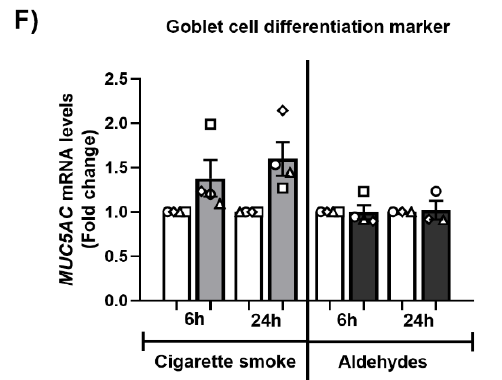
Figure 9. Transcript levels of basal epithelial cell marker KRT5 are decreased in response to CS exposure. Differentiated human primary bronchial epithelial cells (PBEC) from non-COPD subjects ( n = 4 donors) were exposed to smoke of one Marlboro Red cigarette (CS), or a mixture of acetalde- hyde, acrolein, and formaldehyde (at concentrations equivalent to one cigarette), or air (control), under a continuous flow system using a puff-like exposure protocol. After recovery for 6 h or 24 h, whole cell lysates were harvested to analyze transcript levels of basal epithelial cell markers ( A ) KRT5 , ( B ) KRT14 , and ( C ) nuclear basal epithelial cell marker TP63 . Expression levels were analyzed for ( D ) club cell secretory marker SCGB1A1 , ( E ) ciliogenesis marker FOXJ1 , and ( F ) goblet cell differen- tiation marker MUC5AC . Data are presented as mean fold change compared to air control ± s.e.m. The mean values of biological triplicates for each independent donor are represented by open circles, triangles, squares, or diamonds. Statistical differences between CS vs. air and the mixture of aldehy- des vs. air were tested using a two-tailed paired parametric t -test. Statistical significance is indicated as * p < 0.05 vs. air